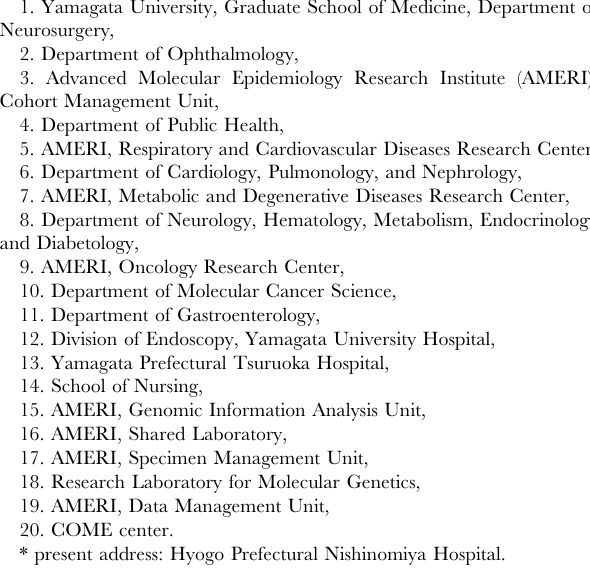
ods S1. Table S1, Associations of imputed genotypes in the ABO locus with P-LIP in Takahata population. Table S2, Associations of imputed genotypes in the ABO locus with ACE in Takahata population. Table S3, Associa- tions of ABO gene in 9q32 with P-LIP or ACE levels after adjustment by smoking or Box-Cox transformation of trait values. Table S4, Associations of ACE1 in 17q23.3 with ACE level after adjustment by smoking or Box-Cox transformation of trait values. Table S5, Associations of ABO gene in 9q32 with P-LIP or ACE levels after adjustment or subgroup by treatment. Table S6, Asso- ciations of ACE1 gene in 17q23.2 with ACE level after adjustment or subgroup by treatment. Table S7, SNPs associated with P-LIP and/or ACE levels at a genome- wide significance level. Table S8, Associations of ABO gene in 9q32 with P-LIP and ACE in combined popula- tion. Table S9, Associations of ACE gene in 17q23.2 with ACE in combined population. Table S10, Sample numbers removed by each quality control filter. Text S1, Organization and all contributors list of Yamagata University Genomic Cohort